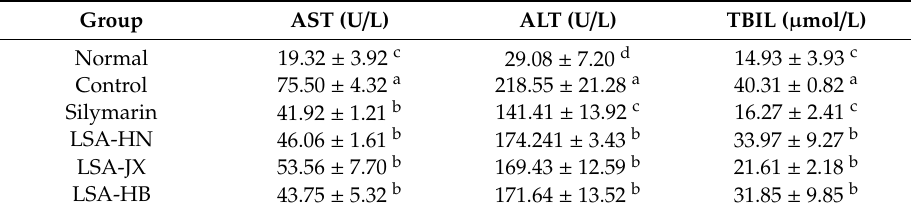
Table 4. The levels of AST, ALT and TBIL in the serum from the mice ( N =